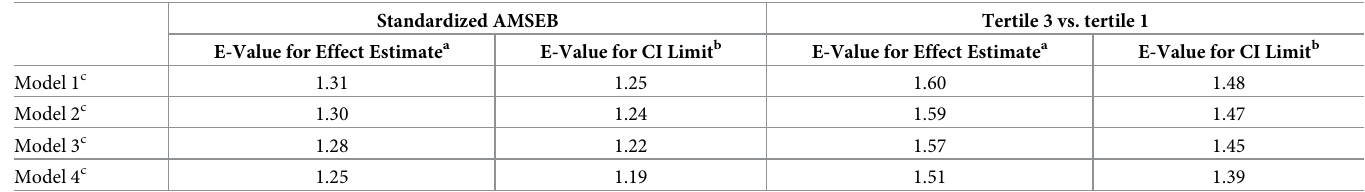
Table 3. Robustness to unmeasured confounding (E-values) for assessing the associations between adherence to moral standards and ethical behaviors (standard- ized values and tertile 3 vs. tertile 1) and subsequent health outcomes in middle-aged and older adulthood, health and retirement study, US d .